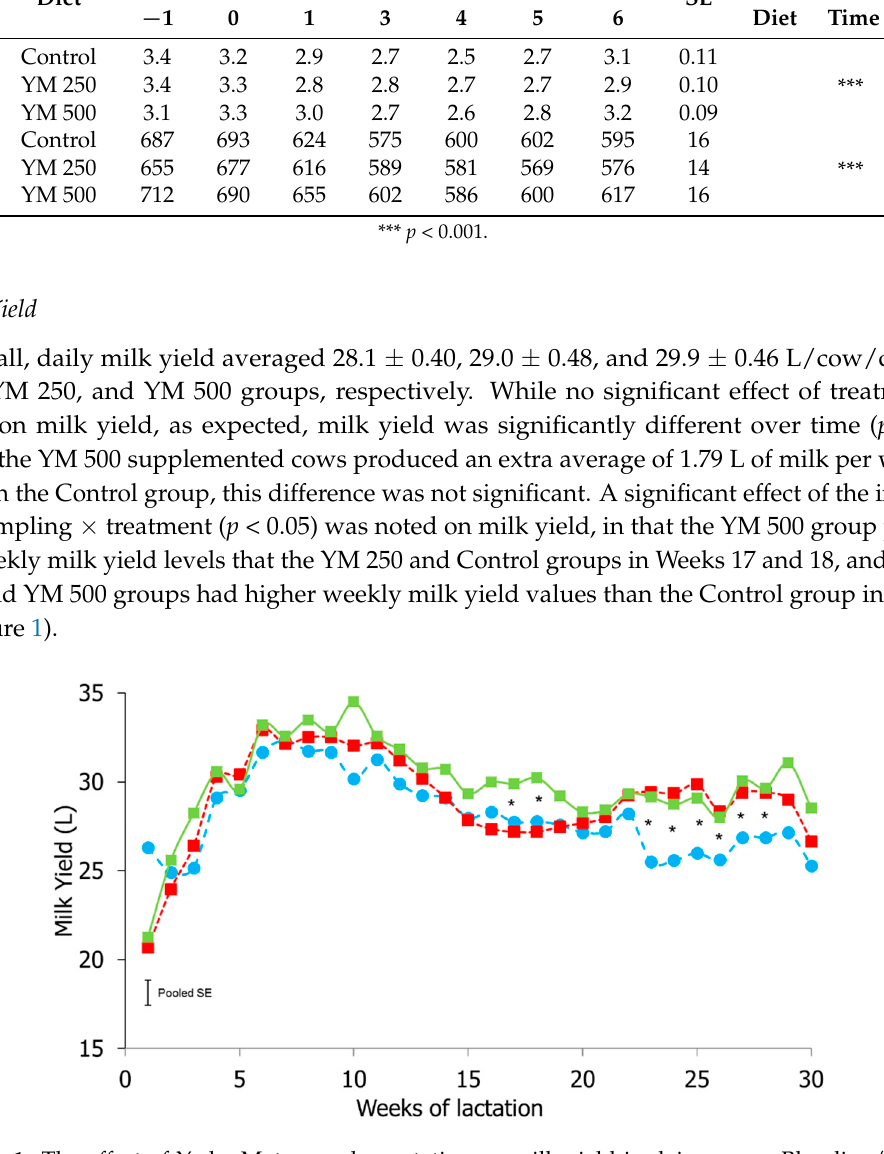
Figure 1. The effect of Yerba Mate supplementation on milk yield in dairy cows. Blue line/circle (Control group), red line/square (Yerba Mate 250), green line/square (Yerba Mate 500). * p < 0.05.